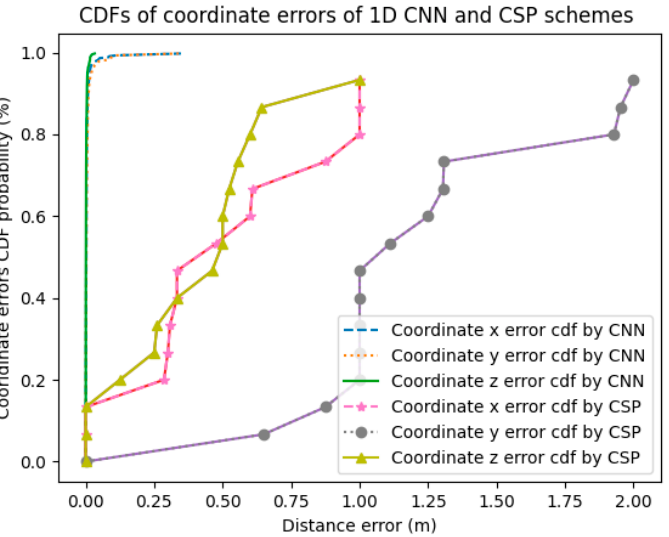
Figure 13. Comparison of classification accuracies of 1D CNN model and CSP algorithm.